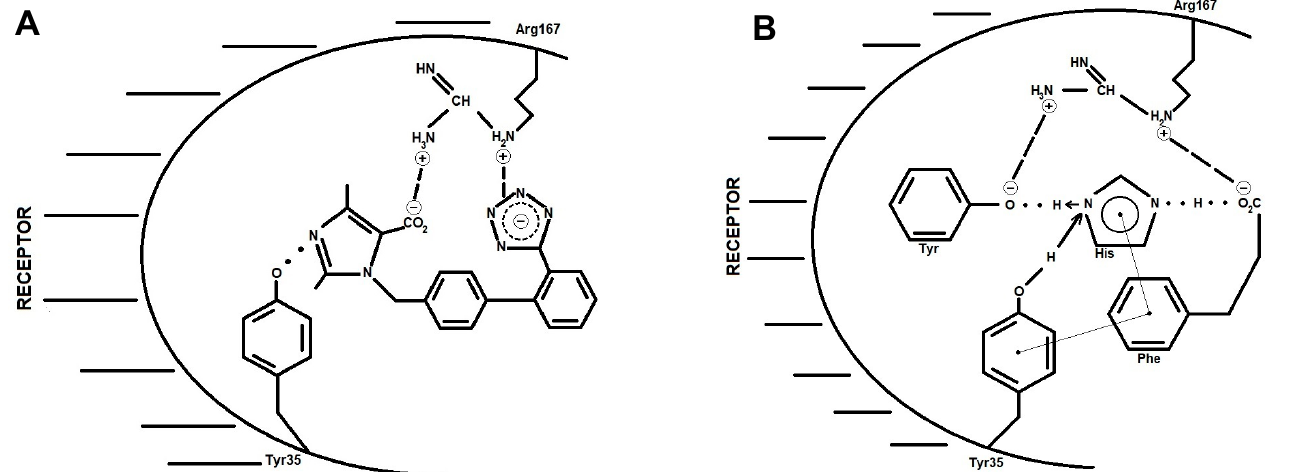
Figure 6. Binding of ( A ) ARB and ( B ) AngII to angiotensin AR1 receptor. ( A ) ARBs characteristically contain a carboxylate and a tetrazole group that form two salt bridges with Arg167 of the receptor, resulting in insurmountable blockade of Ang II. When the carboxylate anion is neutralized, as in losartan (CH2OH) or olmesartan (CONH2 in R239470), and changes the salt bridge to a weaker ion dipole bond, the molecule becomes a surmountable antagonist. ( B ) The charge transfer and separation created by the CRS allows Ang II to bind in a similar manner to ARBs (Figure 5A), though with tyrosinate replacing the carboxylate in ARBs and the C-terminal carboxylate standing in for the tetrazole of ARBs. Like ARBs, the peptide analogue sarilesin can form a salt bridge via its tyrosinate with R167 and is consequently an insurmountable blocker. In parallel with ARBs, the methylation of the TyrOH of sarilesin eradicates this salt bridge and converts it into a surmountable antagonist. In contrast, the presence of the Phe 8 ring in Ang II provides agonist activity by attracting the receptor Y35 ring towards the CRS, eventually allowing the Y35 OH group to H-bond with the His 6 imidazole N of Ang II (exactly equivalent to ARB binding in Figure 5A) and displacing the TyrOH of Ang II so that it no longer carries a charge and cannot form a salt bridge with the R167 of the receptor. This exchange is reversible and requires a cooperative interaction involving the binding of the G protein intracellular messenger and receptor dimerization. When there is no more available G protein (at supramaximal doses), Ang II can bind just like sarilesin and become an insurmountable blocker, invoking tachyphylaxis.